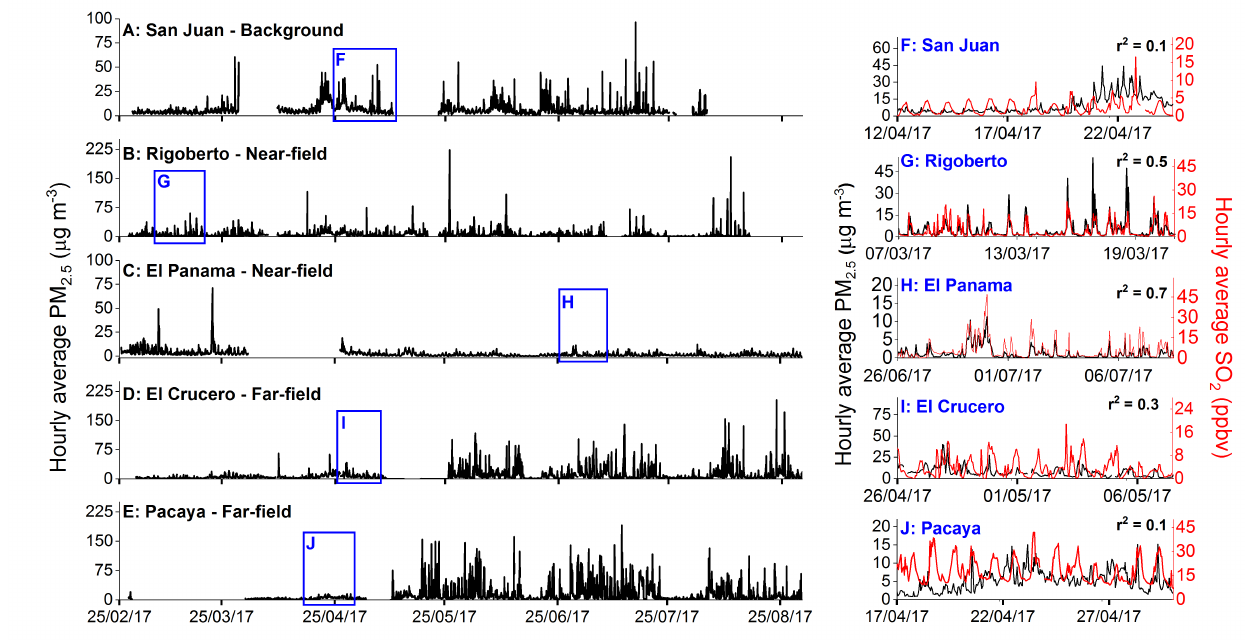
Figure 9: PM 2.5 measurements from the five AQMesh stations. [A–E]: timeseries of hourly-average PM 2.5 mea- surements over the six-month experiment period, with all results corrected for humidity using the method outlined in Section 2.4. Periods of missing data result from lack of power due to corroded battery connectors or batteries remaining uncharged after four weeks. Blue outlines indicate time-periods for F–J. [F–J]: 14-day excerpts from the PM 2.5 timeseries at each AQMesh station. SO measurements for the same time-period indicated by the red data- 2 line, with corresponding scale on the right-hand y-axis. Correlation between PM 2.5 and SO for the excerpt period 2 is indicated in the top-right corner of each plot. Time-periods for the 14-day excerpts were chosen where PM 2.5 and SO data were both available (with no extreme SO peaks or troughs), and where there were simultaneous 2 2 elevations of SO and PM, if 2